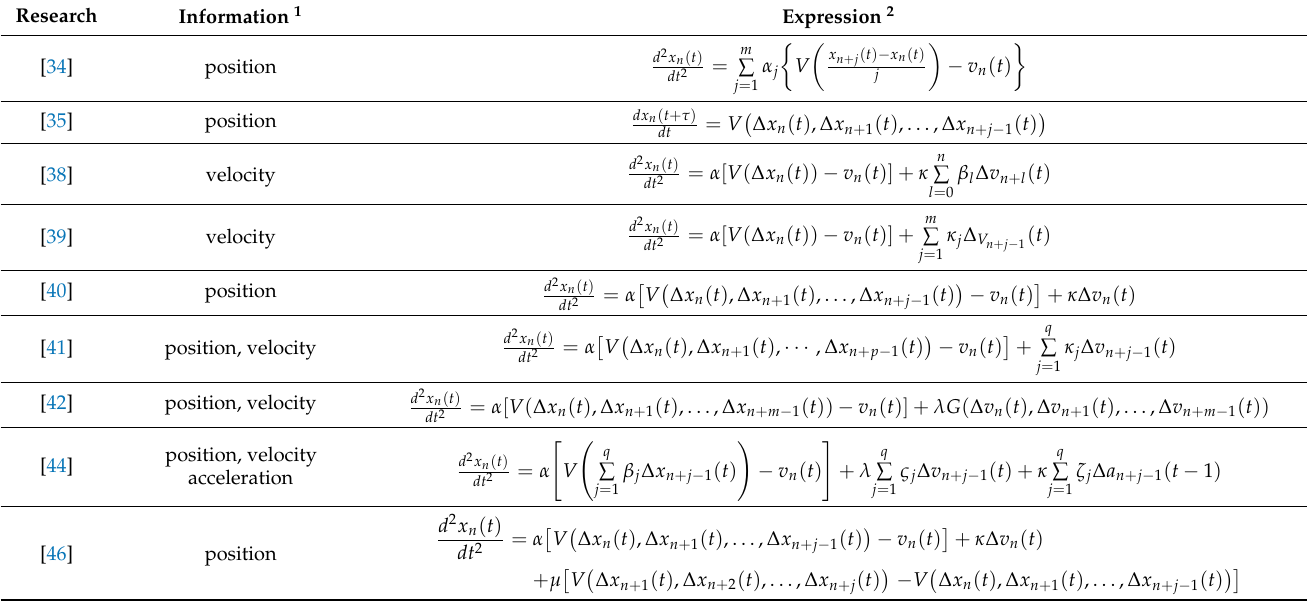
Table 1. Incorporated information in the above models and their